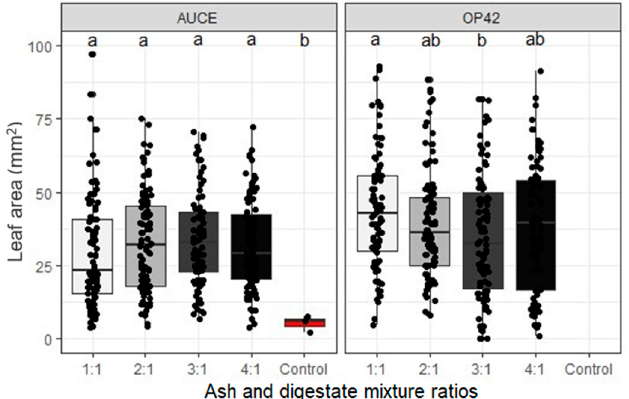
Figure 3. Influence of different ratios of wood ash and digestate on leaf area (mm 2 ) for ‘AUCE’ and ‘OP42’ poplar clones. Different letters indicate significant differences ( p < 0.05) using the ‘Pairwise Wilcox’ test.